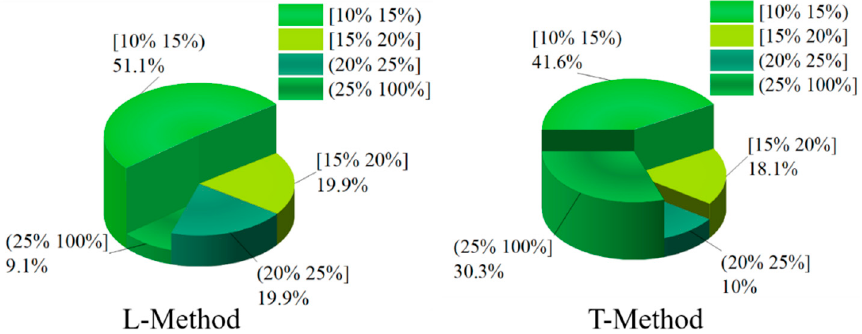
Figure 14. Ratio of front-left wheel slip under different control strategies.